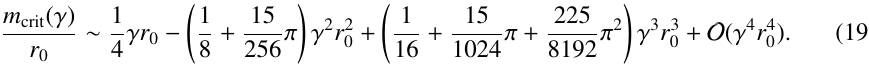
, where γ 1 . 6657 10 − 3 r − 1 0 × ∗ ∗ ≃